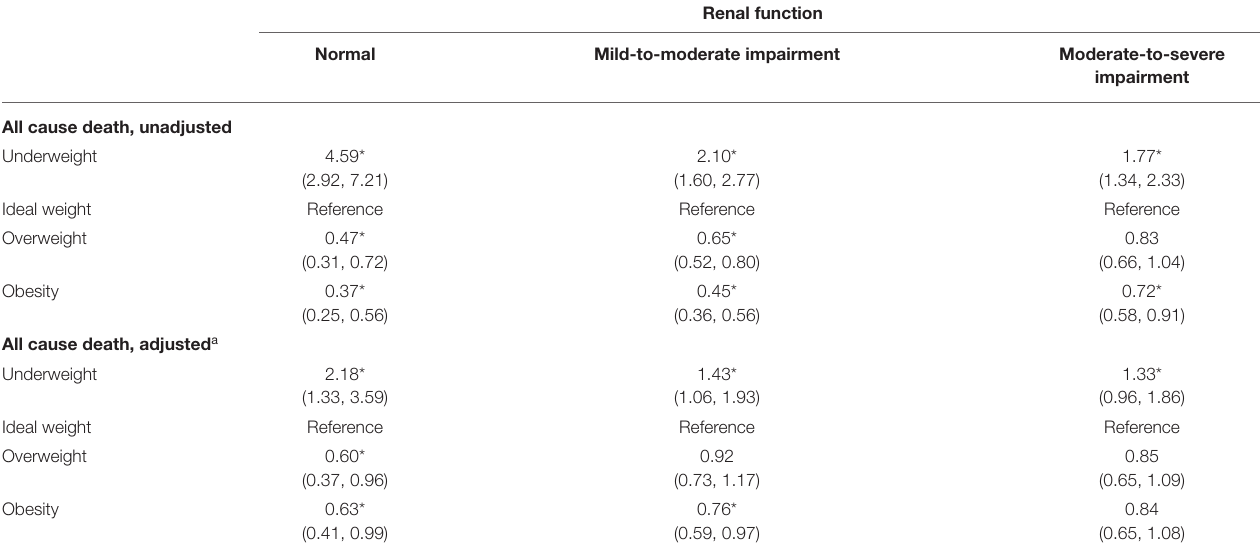
TABLE 2 | Hazard of all-cause mortality by BMI groups based on renal function